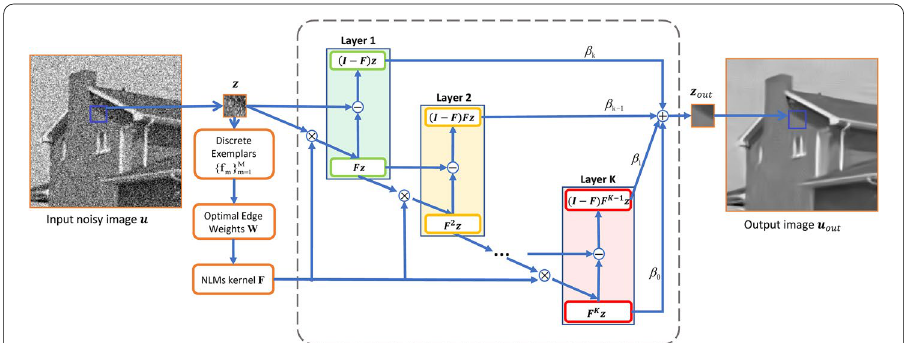
Fig. 1 Flowchart of the proposed